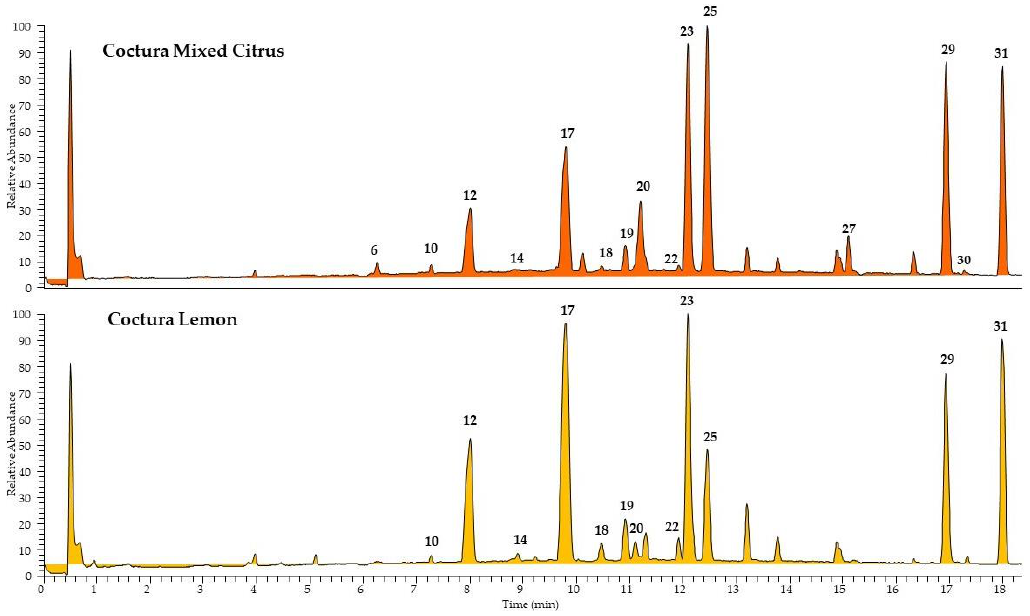
Figure 1. UHPLC-HR-ESI-MS/Orbitrap profiles, registered in negative ionization mode, of n -butanolic extracts of Lemon and Mixed Citrus products. Peak data are shown in Table 4. Table 4. Chromatographic and mass spectrometry data of compounds identified in the analysed samples: Coctura Mixed Citrus (A), Coctura Lemon (B), Orange peel (C), Mandarin peel (D), Lemon peel (E), Orange pulp (F), Mandarin pulp (G), Lemon pulp (H). Peak numbers correspond to those of Figures 1 – 3.